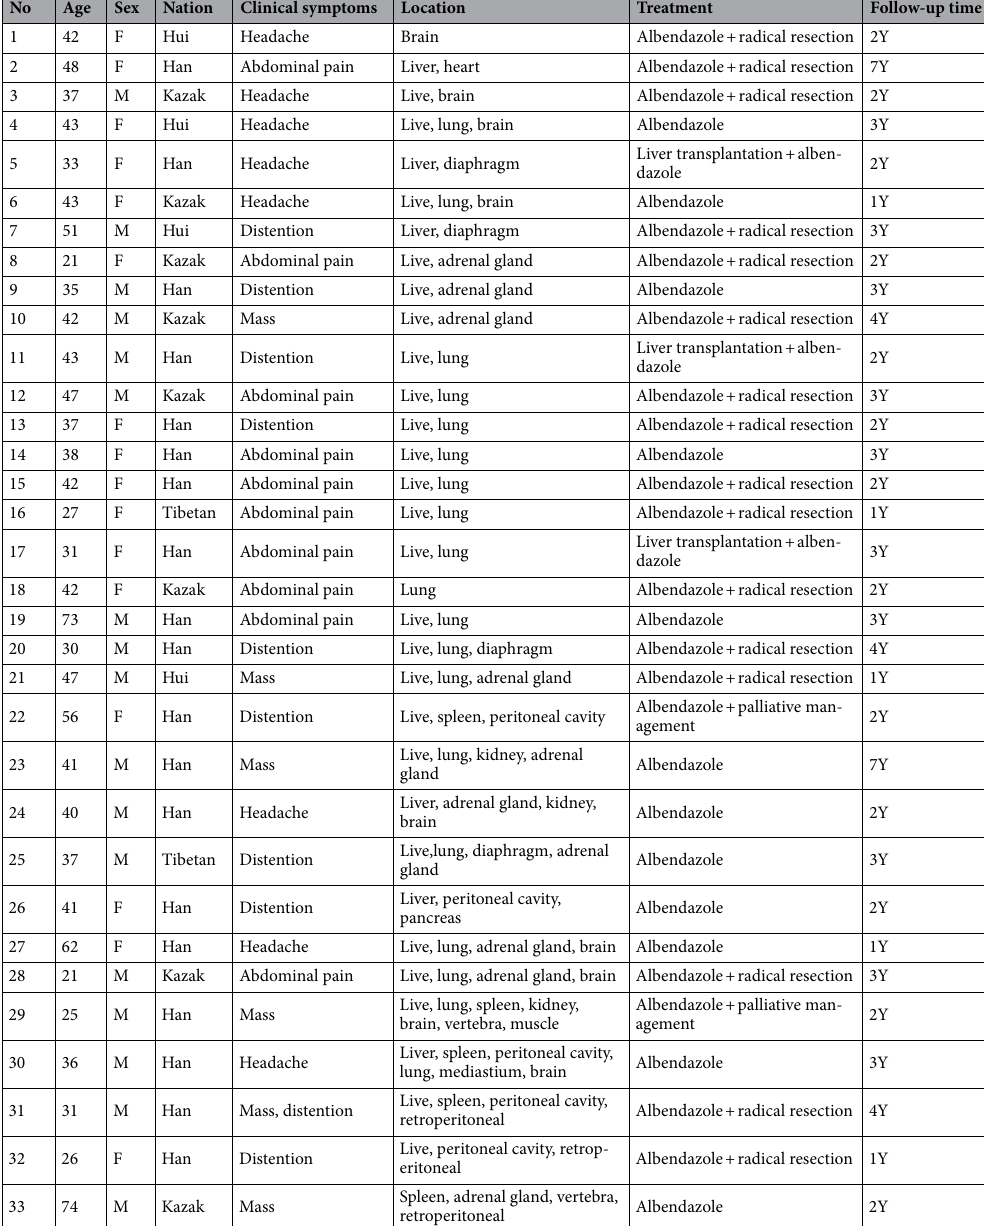
Table 1. The demographic characteristics and the distribution of AE lesions of 33 cases. M Male, F Female, Y